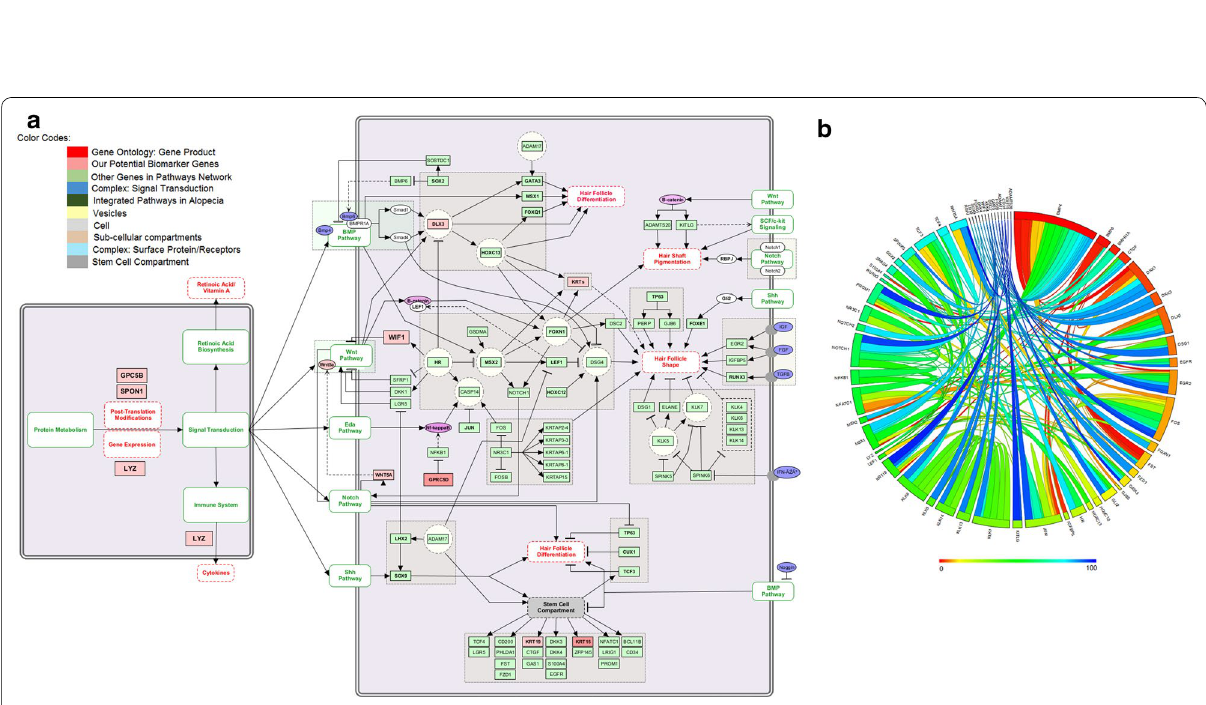
Fig. 6 Protein–Protein Interaction Network. Interaction of seeder/source nodes (light yellow and red) with target nodes (light blue). The topological properties of the network were analyzed by Network Analyzer